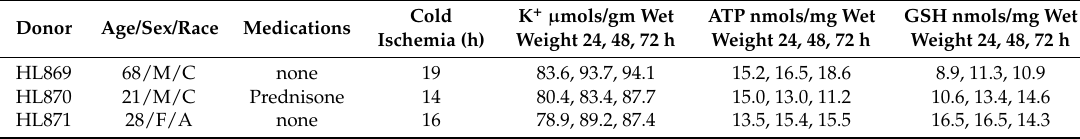
Figure 1. Time course of ATP and GSH levels (24–72 h) in human liver slices exposed to daily dosing of APAP (1 mM), DCF (1 mM), MMI (500 µ M), TBF (100 µ M), CBZ (100 µ M), ETM (100 µ M), DTL (10 µ M), CSA (10 µ M). Values were determined in 10 control slices or 6 treated slices/time-point/liver. Statistical significance, p < 0.05, is labeled (*) and related to the time-matched control value. Table 1. Human donor information and markers of human liver slice viability (K + , ATP and GSH levels) in control slices (24–72 h) to verify the quality of the tissue for the duration of the